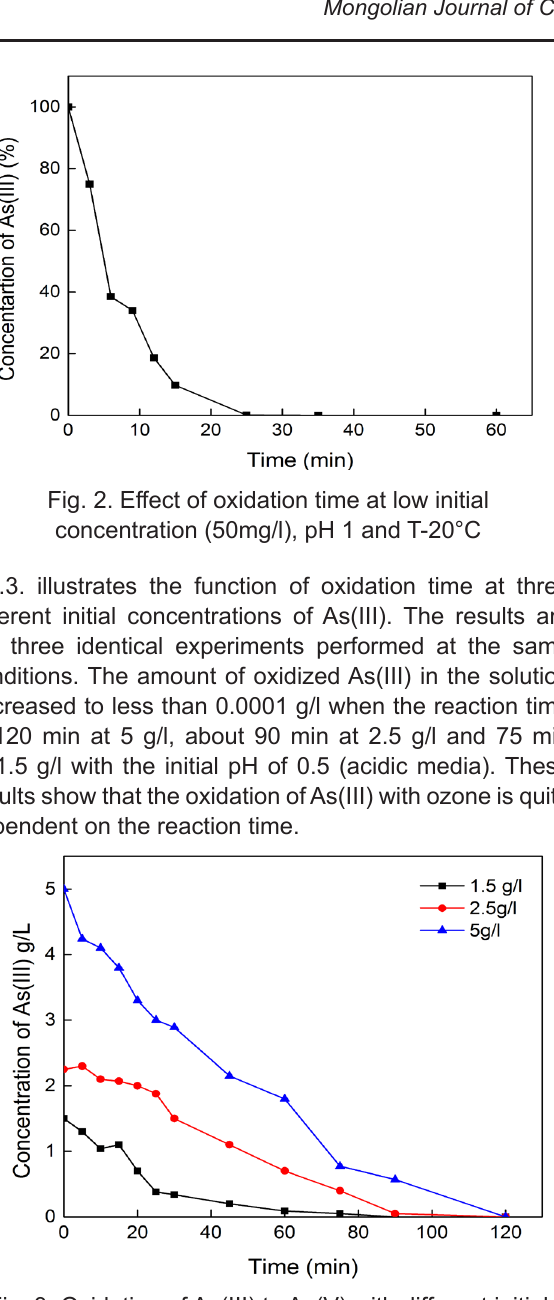
Fig. 3. Oxidation of As(III) to As(V) with different initial concentrations (pH 0.5, 20°C)